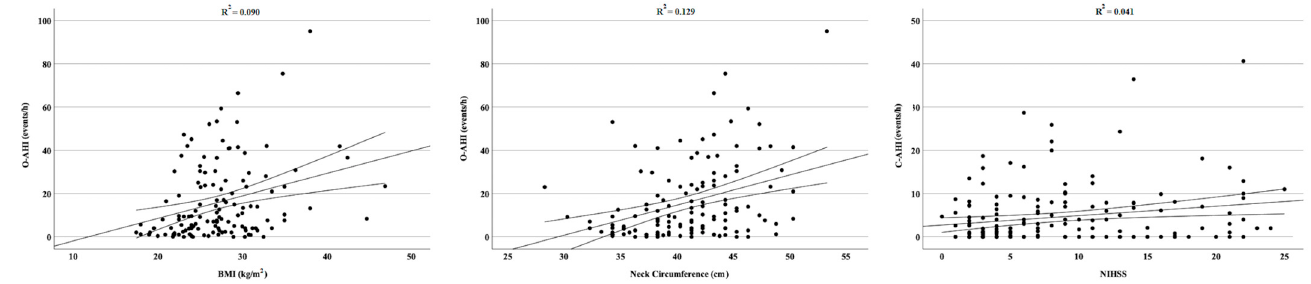
Figure 2. A positive significant correlation was observed between O-AHI and BMI, O-AHI and neck circumference, and C-AHI and stroke severity.